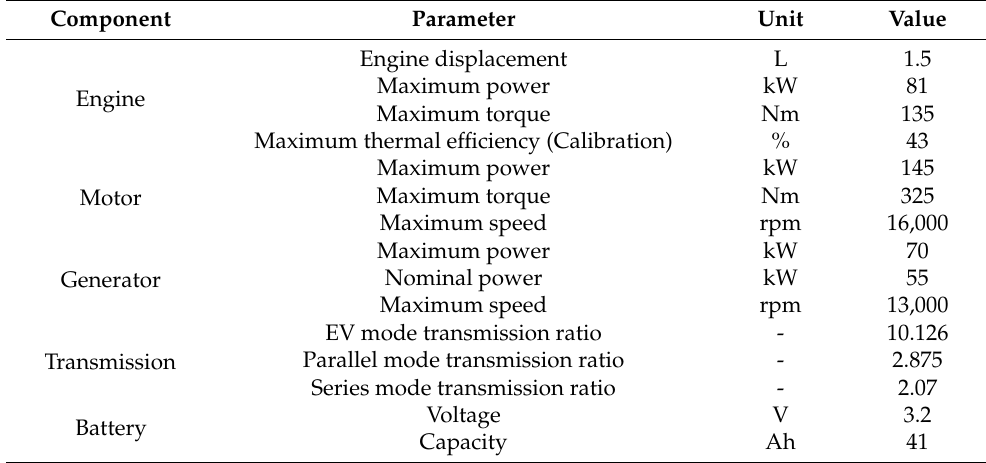
Table 2. Component’s